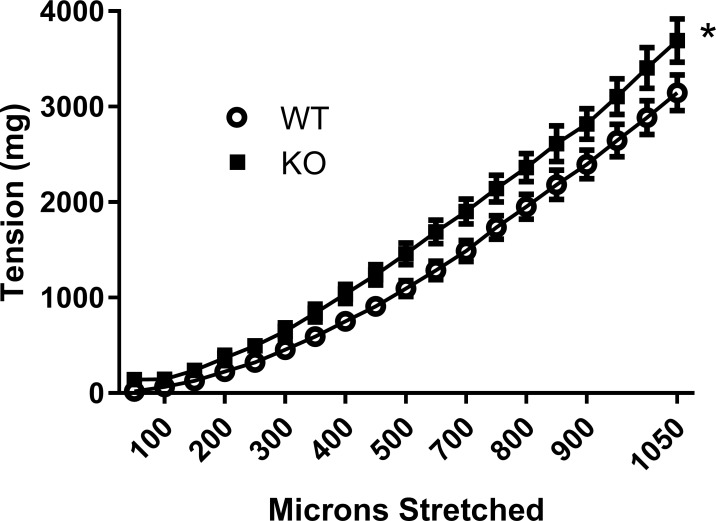
Length-tension relationship for aorta from wild-type (WT) and Slc29a1-null (KO) mice.Tissues were incubated for 30 min at 22°C in KPSS buffer with no resting tension, prior to increasing tension in 50 micron increments. Each point represents the mean ± SEM, N = 7. *Significant difference between aortas from wild-type and Slc29a1-null mice (Two-Way ANOVA for unpaired experimental parameters, P<0.05).